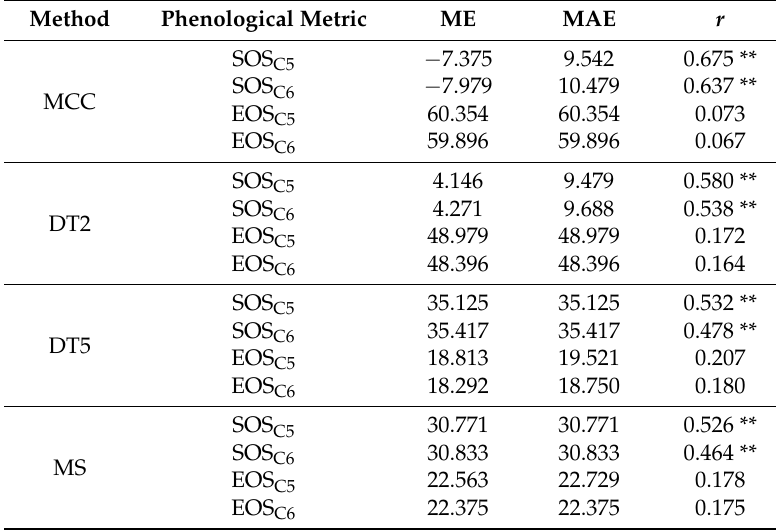
Table 4. Mean error (ME), mean absolute error (MAE) and correlation coefficient ( r ) between the satellite-derived phenology and the ground-observed